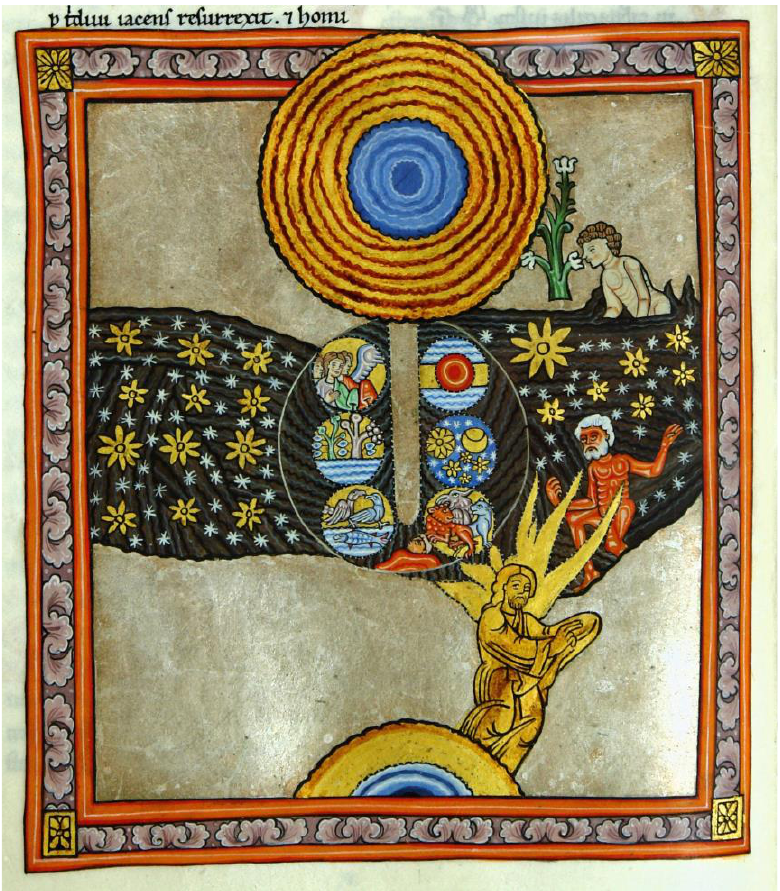
Figure 4. Scivias 2.1: Creation and the Redeemer. Rüdesheim/Eibingen, Benediktinerinnenabtei